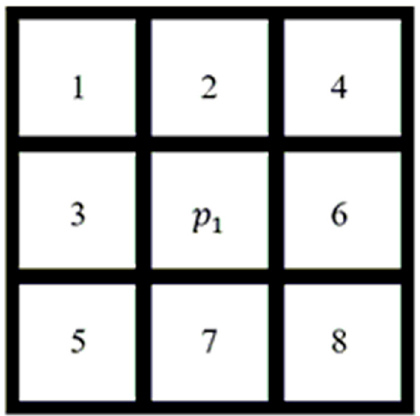
Figure 5. Arrangement order of pixels in the road tracking algorithm.